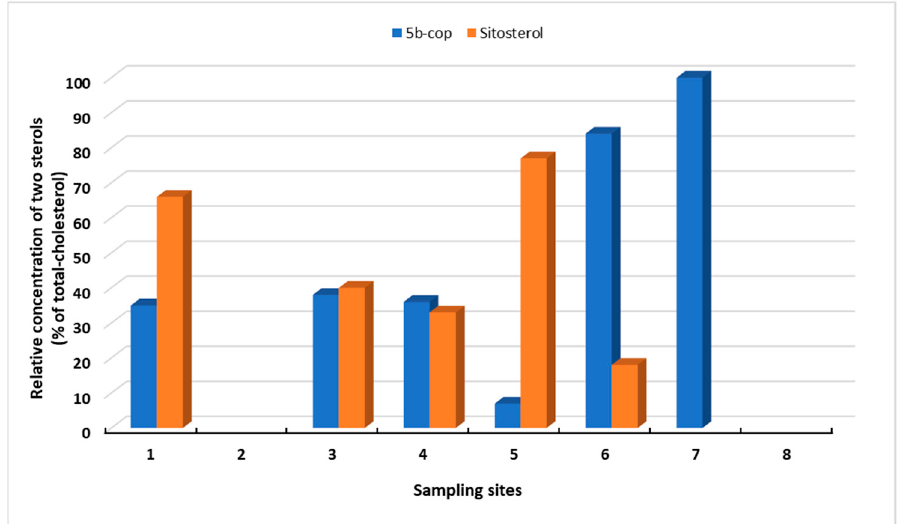
Figure 4. The relative concentrations of coprostanol (5b-cop) and sitosterol in water samples, as calculated from the total sterol concentration minus cholesterol, at various sites around Blakeney as determined during a low tide period. (1) Simpoles Head, (2) Freshers Creek, (3) Mortson Creek, (4) Blakeney Harbour, (5) Blakeney Harbour Sluice, (6) Scaupe Run, (7) River Cley (below weir), (8) River Cley (above weir).